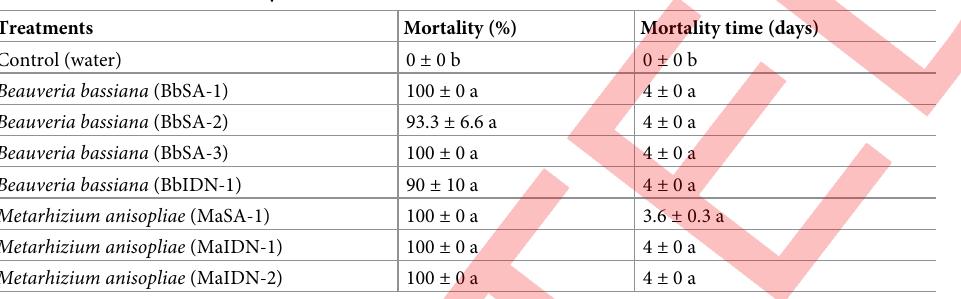
Table 2. Mean mortality (% ± SE) of red palm weevil eggs treated with Metarhizium anisopliae and Beauveria bassiana isolates under laboratory conditions.